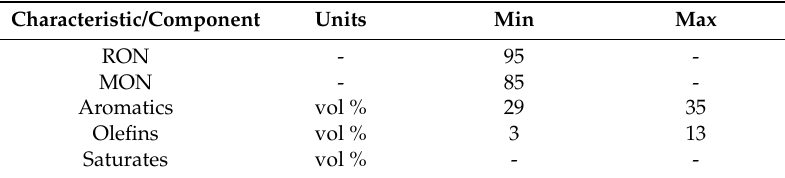
Table 2. Reference fuel properties.